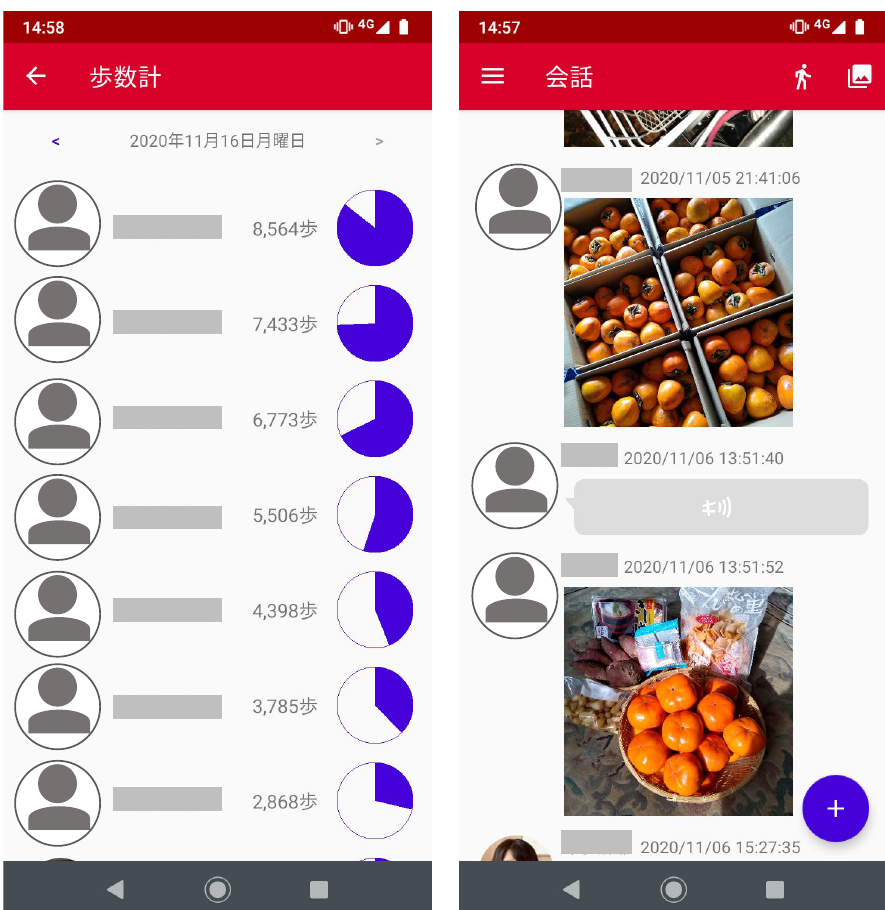
Figure 1. Screenshot of the communication application used in this study. Participants send photos to each other and rank their step count. Note. “ 歩数計 “on the app’s screen represents the step count, “ 会話 “ represents conversation, and ”2020 年 11 月 16 日月曜日 ” represents Monday